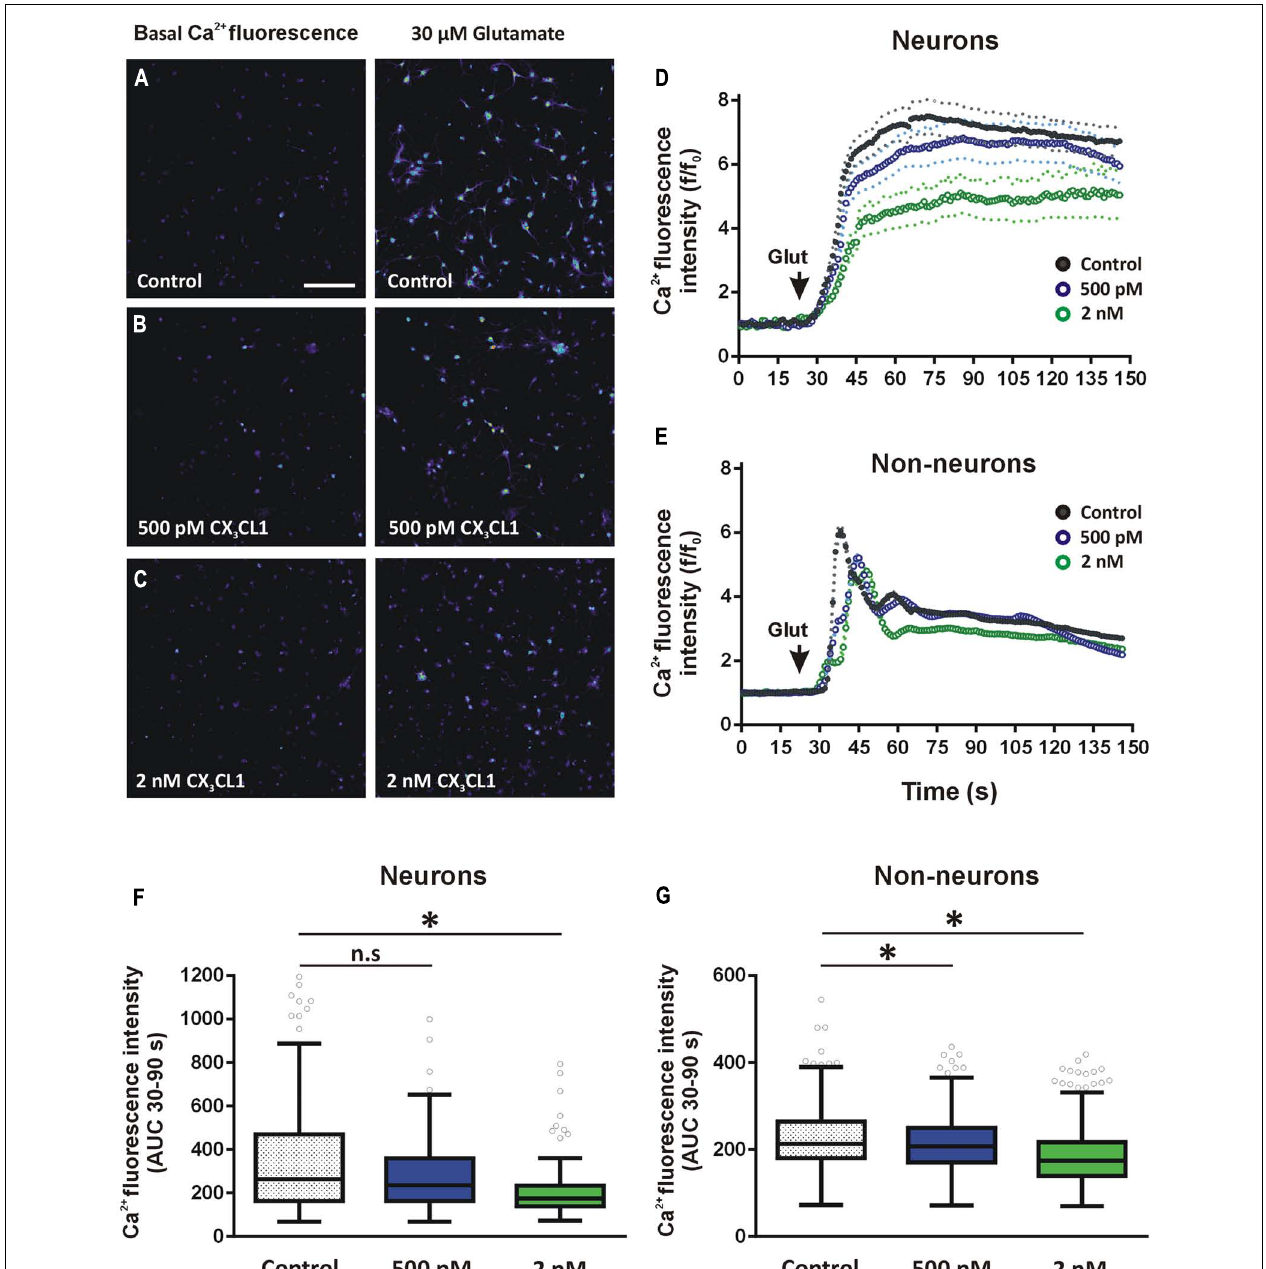
FIGURE 5 | Effect of CX 3 CL1 on glutamate-induced calcium dynamics in neurons and glia. (A–C) Representative images of intracellular calcium [Ca 2 + ] i levels in mixed neuron-glial primary hippocampal cultures before and after 30 μ M glutamate exposure. Control cells (A) were untreated prior to glutamate exposure.Treated cells were exposed to either (B) 500 pM or (C) 2 nM CX 3 CL1 for 15 min. Scale bar = 200 μ m. (D,E) Shows the time-course of the [Ca 2 + ] i response to glutamate in neurons (D) and non-neuronal cells (E) . Cells were treated for 15 min with either 500 pM (blue circles) or 2 nM (green circles) CX 3 CL1 for 15 min prior to 30 μ M glutamate exposure. Untreated control time-course is represented by black circles. Relative changes in [Ca 2 + ] i were calculated for each cell at each time point as f / f 0 , where f is the [Ca 2 + ] i fluorescence in each frame and f 0 is the